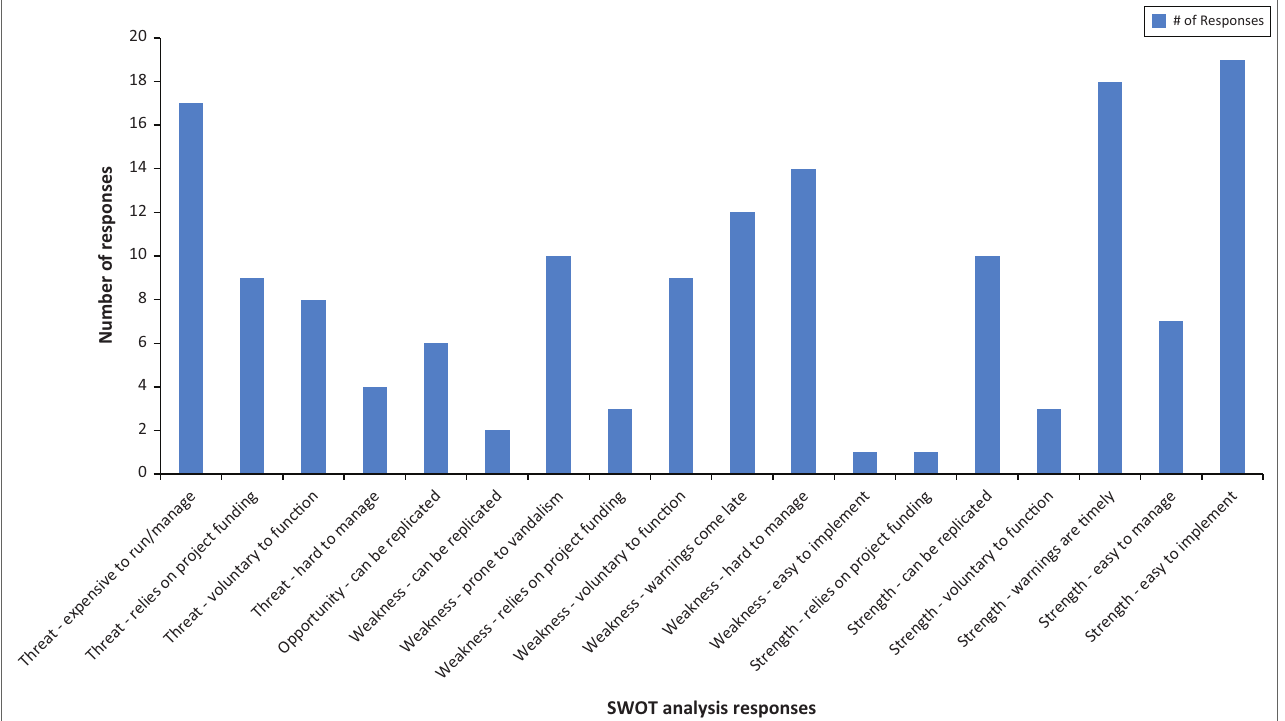
FIGURE 5: Community-based early warning systems SWOT